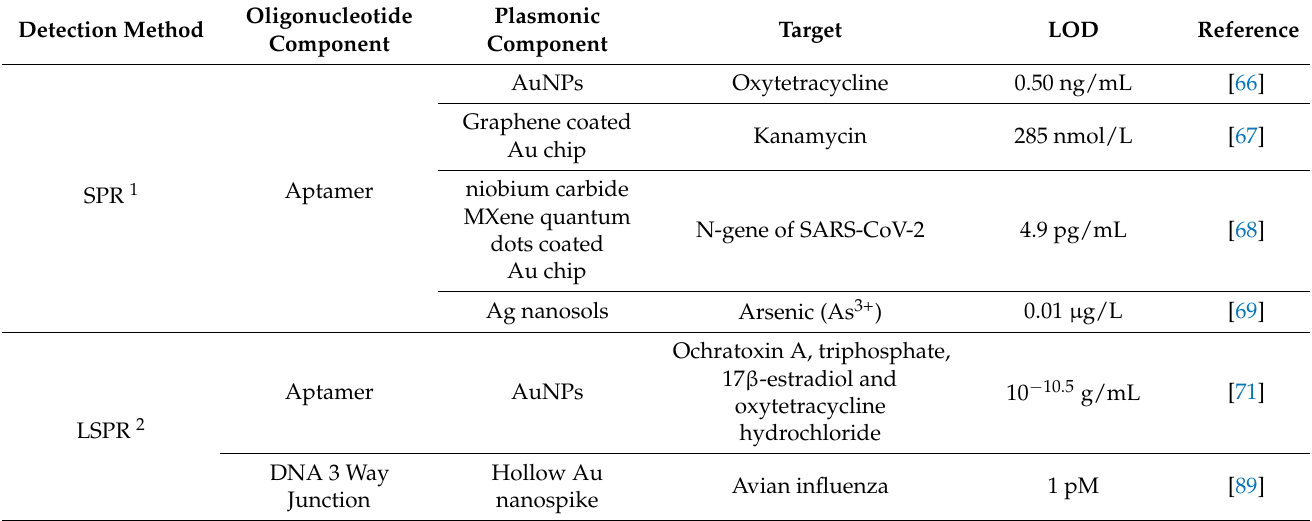
Table 1. DNA nanotechnology for plasmonic biosensor construction. Detection